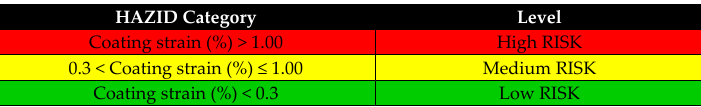
Figure 13. Risk categories of coating cracking according to strain rate for the coating crack.